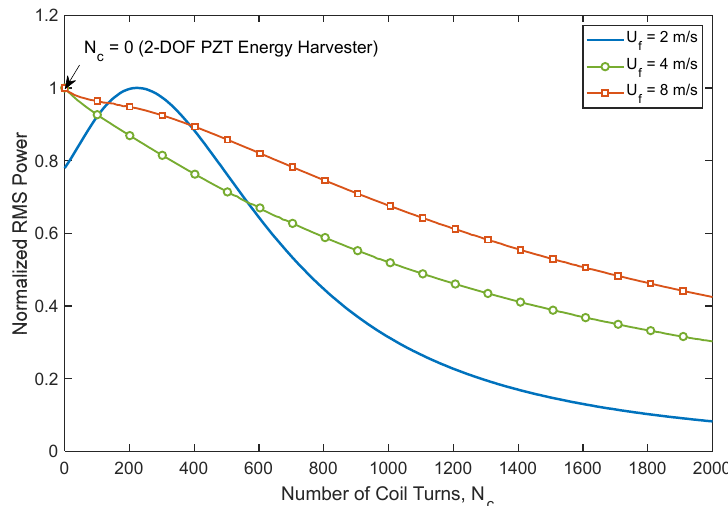
Figure 17. Power vs. number of turns of EM coil inside the bluff body of the hybrid harvester.